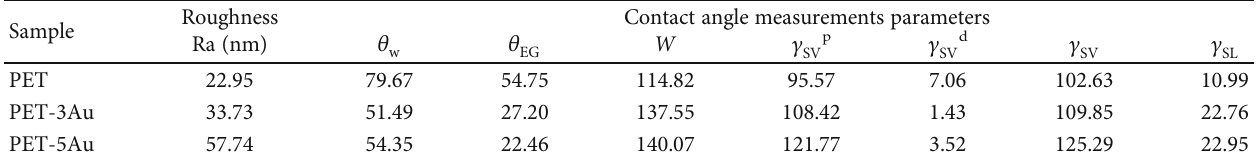
Table 1: Surface roughness and wettability